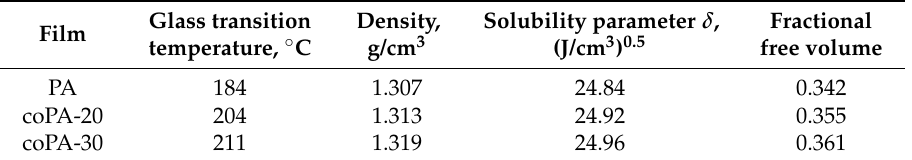
Table 1. Physical properties of polymer films.